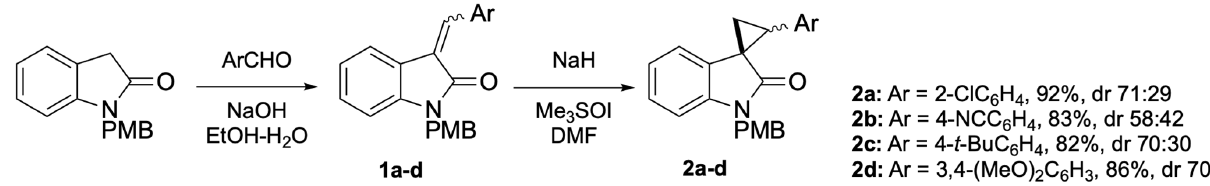
Figure 3. Synthesis of SCOs 2 .